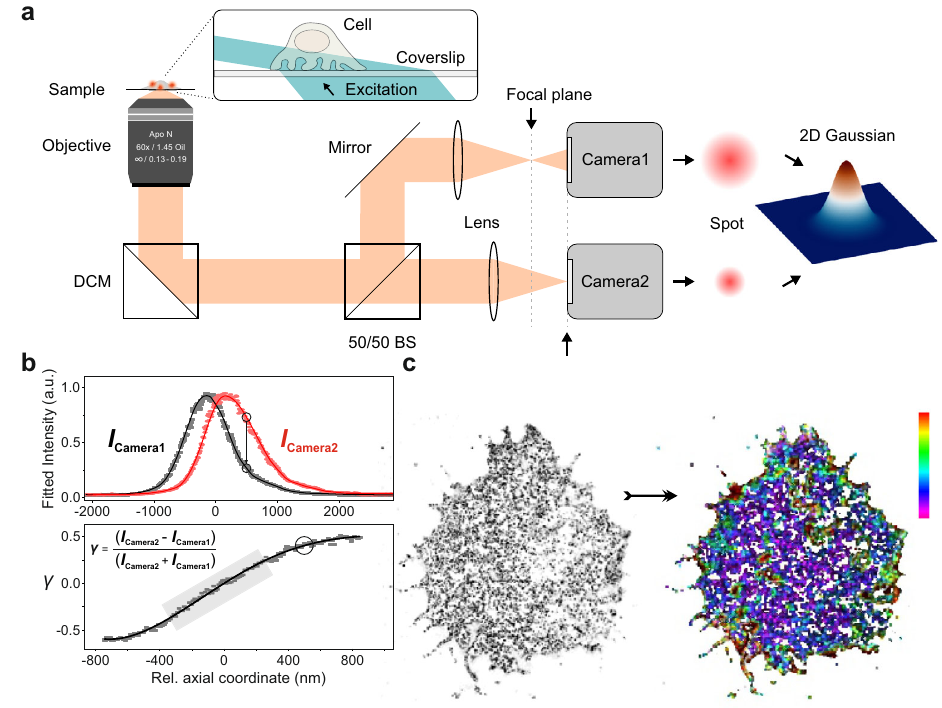
Fig. 2 Principle of 3D super-resolution biplane imaging using dTRABI. a Overview of the experimental setup applied to perform 3D dTRABI imaging of T cells. HILO illumination of the sample (blue beam; only shown in enlarged box) triggers fl uorescence emission (orange), which is split by a 50/50 non- polarizing beamsplitter (50/50 BS) to acquire biplane images on two separate EM-CCD cameras. The respective imaging lenses are shifted along the optical axis to induce a relative defocus of the image detection on synchronized cameras. Spots, apparent in both detection planes, are fi tted by a Gaussian with identically set FWHM. b Using a piezo stage, the focal plane was linearly moved through the sample plane while imaging a single-molecule surface under dSTORM conditions. Hereby, both cameras were synchronized. Fitting the raw PSFs by independent Gaussians with invariable FWHM yielded axially dependent single-molecule intensity curves (upper panel). The relative change of position of the imaging lens in the re fl ection path is mirrored by the relative shift of the respective intensity curve (indicated by circles). Data points were spline interpolated to guide the eye (solid lines). An axially precise calibration function γ is derived directly from the raw intensities ( I Camera1 , I Camera2 ) of corresponding localizations from both cameras as γ generate the basis of the axial lookup table (lower panel). c A two-dimensional high-resolution data set is generated from both image stacks (transmission and re fl ection path) to create a three-dimensional dTRABI data set according to the calibration. Finally, the transmission localization set is used to render a high-resolution, axially color-coded image of the focused target structure. Scale bars, 5 μ